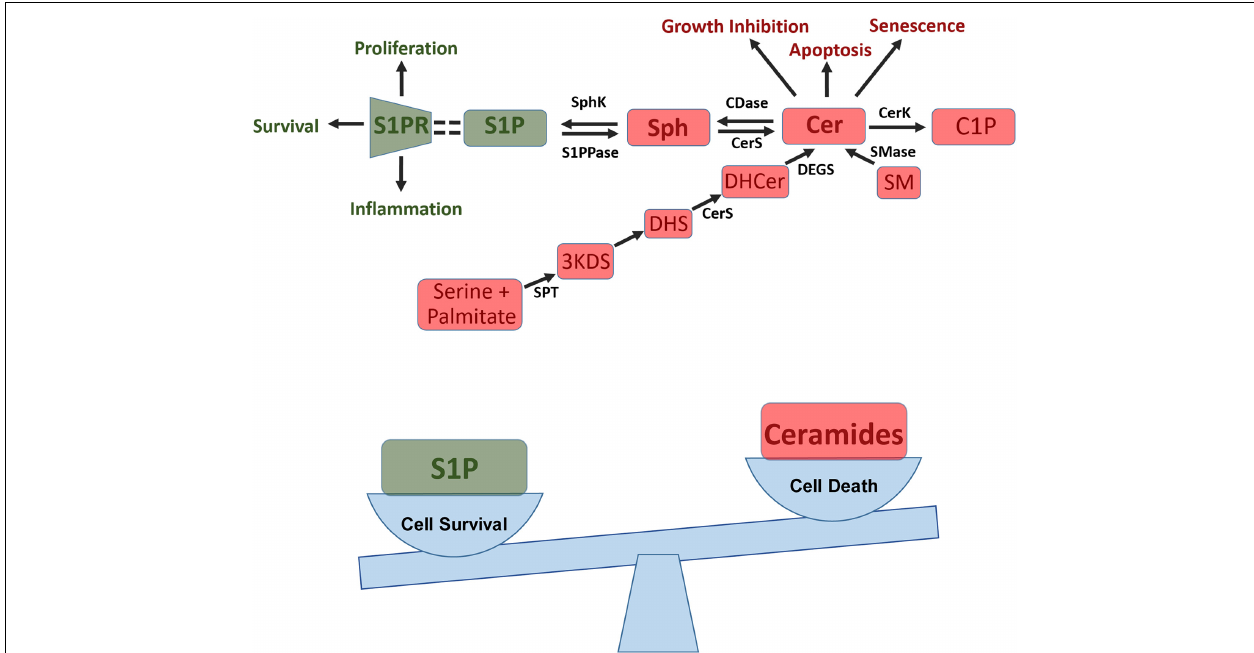
FIGURE 1 | Sphingosine-1-phosphate (S1P) pathway and the sphingolipid rheostat. Top: S1P pathway summary showing how ceramide (Cer) is formed de novo from conversion of serine and palmitate into 3-keto-dihydrosphingosine (3KD) via serine palmitoyl transferases (SPT). 3KD is then reduced to dihydrosphingosine (DHS) and converted to dihydroceramide (DHCer) by ceramide synthase (CerS). Finally DHCer is converted to Cer by dihydrogceramide desaturase (DEGS). Cer can also be produced from sphingomyelin (SM) in the salvage pathway through sphingomyelinase (SMase). Cer can then be used to generate ceramide-1-phosphate (C1P) and can impact apoptosis, senescence, and growth inhibition. Additionally, Cer can be converted to sphingosine (Sph) via ceramidase (CDase), this process can then be reversed via CerS. Sph can then be converted into S1P via sphingosine kinases (SphK), a process which can be reversed via S1P phosphatase (S1PPase). S1P then binds to S1P receptors (S1PR) on cells to induce proliferation, cell survival, and inflammation. Bottom: Sphingolipid rheostat showing how the balance between pro-survival S1P and pro-apoptotic ceramide influences a cells ability to survive and